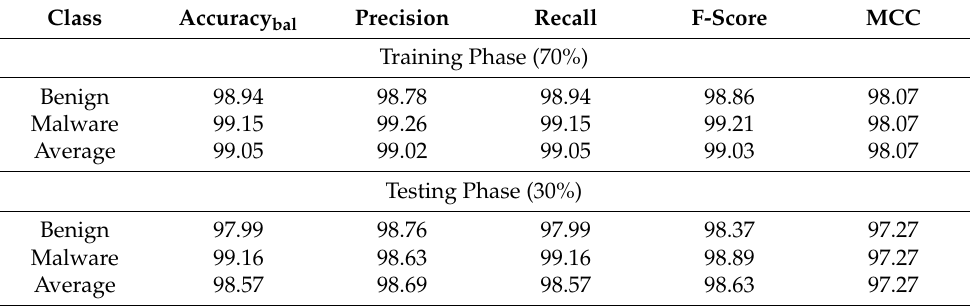
Table 3. Android malware detection outcome of RHSODL-AMD system at 70:30 of TRS/TSS. Class Accuracy bal Precision